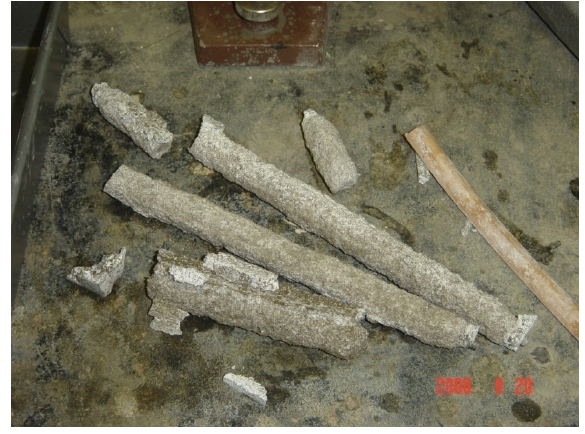
Figure 2. Mortar bars severely deteriorated after immersion in NaOH solution for 63 days.